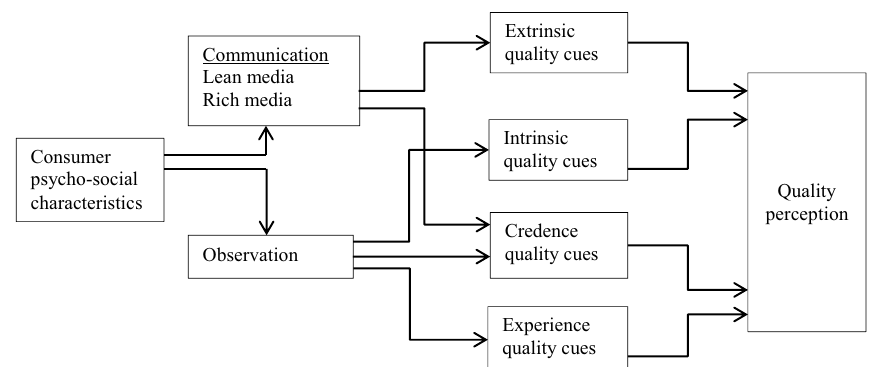
Fig. 1 Research framework integrating the food quality guidance model and media richness theory. Source : Own elaboration based on Luning, Marcelis, and Jongen (2002)